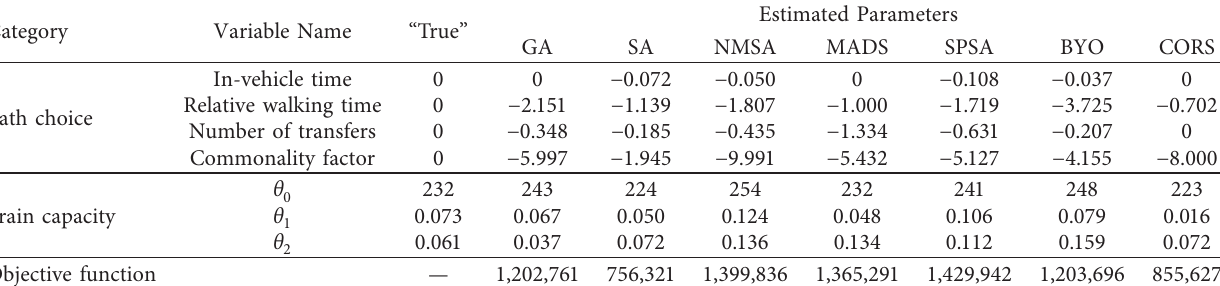
Table 5: Estimation results of the random path choice scenario.